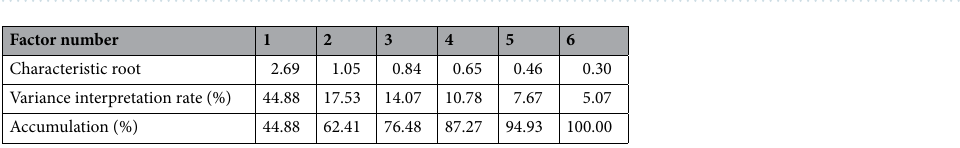
Table 2. Interpretation rate of variance.